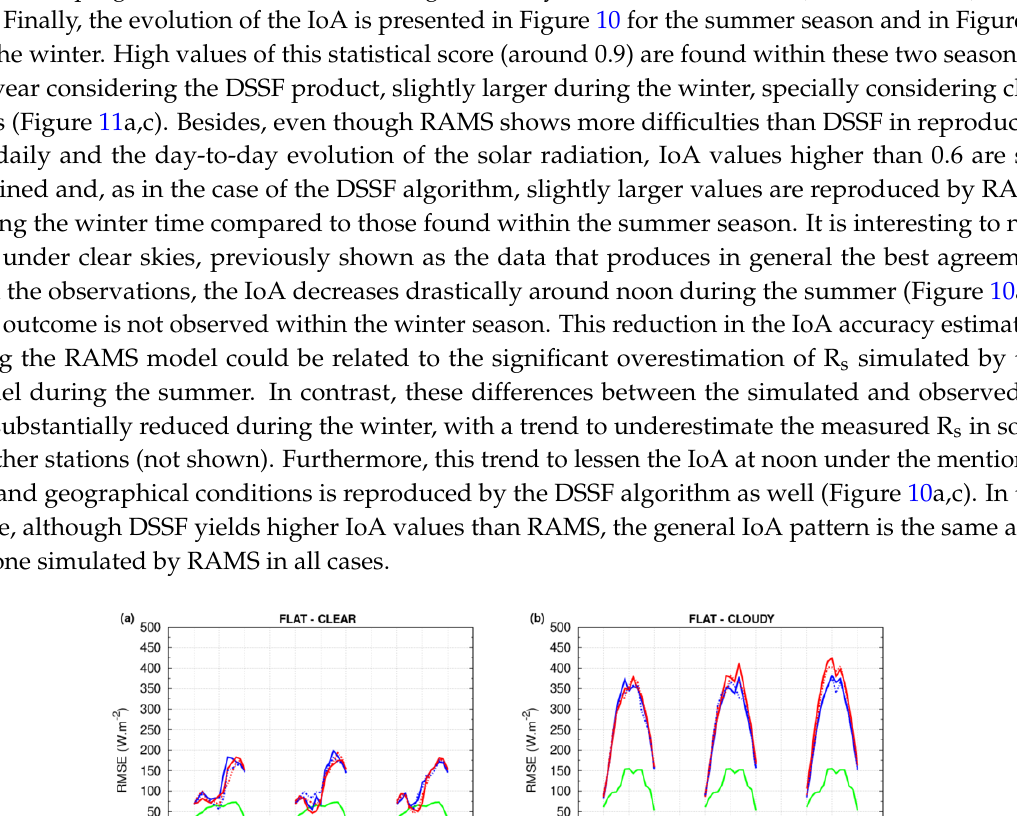
Figure 9. Same as Figure 7, but for the RMSE (W·m − 2 ) statistical score: flat-clear ( a ); flat-cloudy ( b ); hilly-clear ( c ) and hilly-cloudy ( d ).